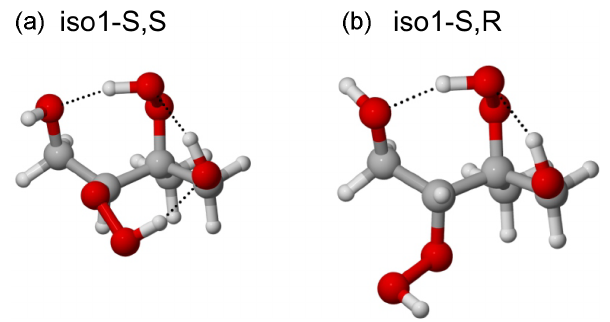
Figure 4. Lowest-energy conformers (at the BP/def2- TZVPD//BP/def-TZVP level, with COSMO solvation, using the Systematic configurational sampling scheme) of the S,S ( a ) and S,R ( b ) stereoisomers of structural isomer 1 of ISOP ( OOH ) 2 . The S,R stereoisomer only has two intramolecular H-bonds in the lowest-energy conformer, while the S,S isomer has three. Corre- spondingly, the saturation vapor pressure of the S,R stereoisomer is predicted to be lower by a factor of 15. Color coding: gray is C, red is O, and white is